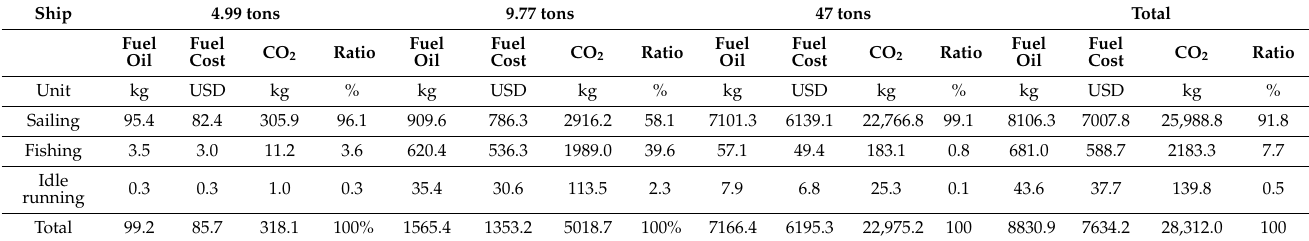
Table 1. Fuel oil consumption, fuel cost, and CO 2 emissions of reference fishing boats.